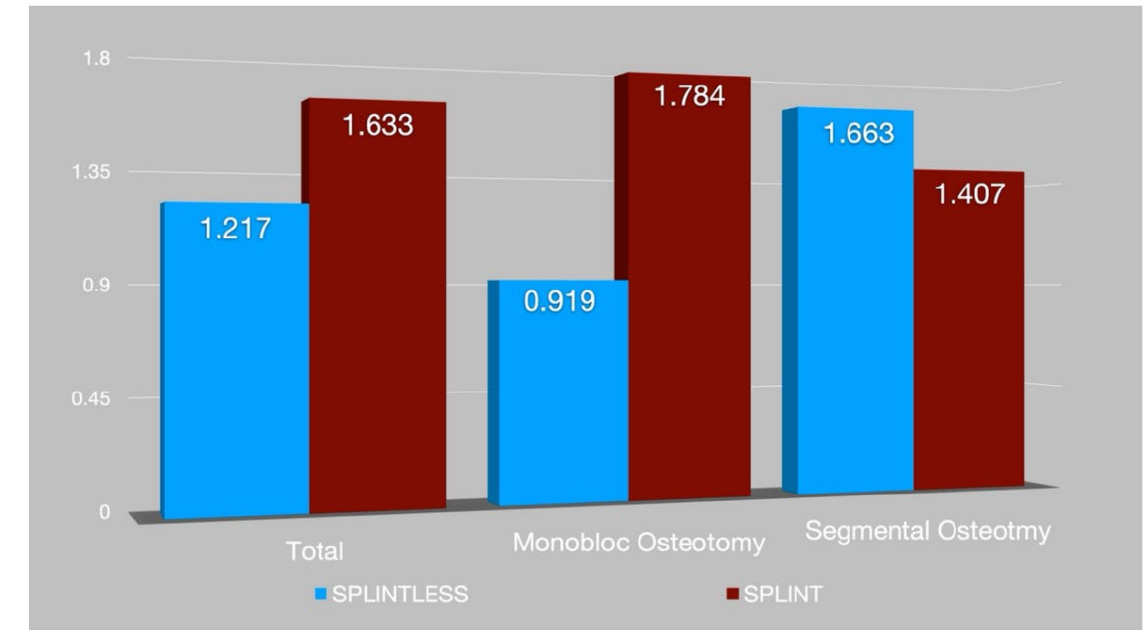
Figure 6. Histogram showing 3D comparison (RMSE) in the three groups analyzed.